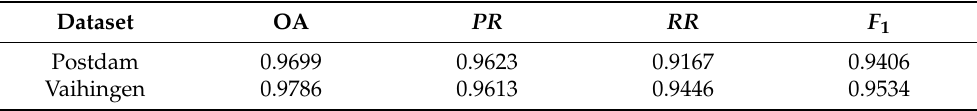
Table 5. The average accuracy for precision, recall, as well as F1 score for buildings in Potsdam and Vaihingen (OA denotes overall